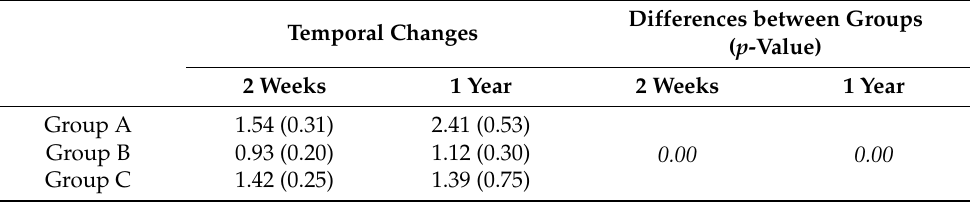
Table 7. Pocket depth analysis while probing: temporal changes and differences between groups. Temporal